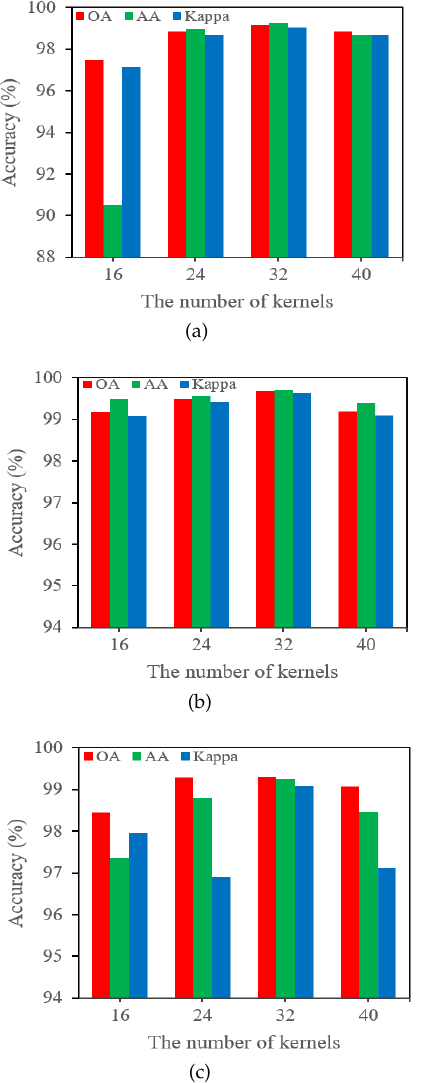
Figure 11. Accuracy (%) of SSCRN with different numbers of kernels on three datasets: ( a ) IP, ( b )